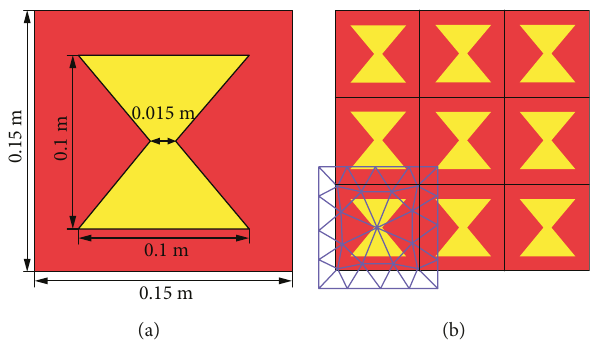
Figure 14: (a) The dimension of a bowtie antenna element and (b) 3 × 3 bowtie antenna array.